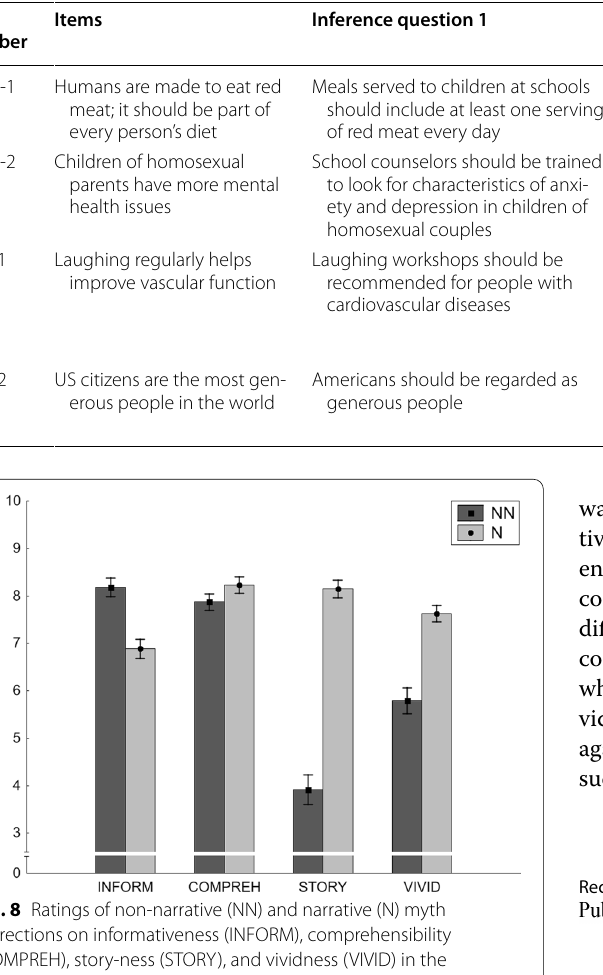
Table 11 Myths and facts, and corresponding inference questions